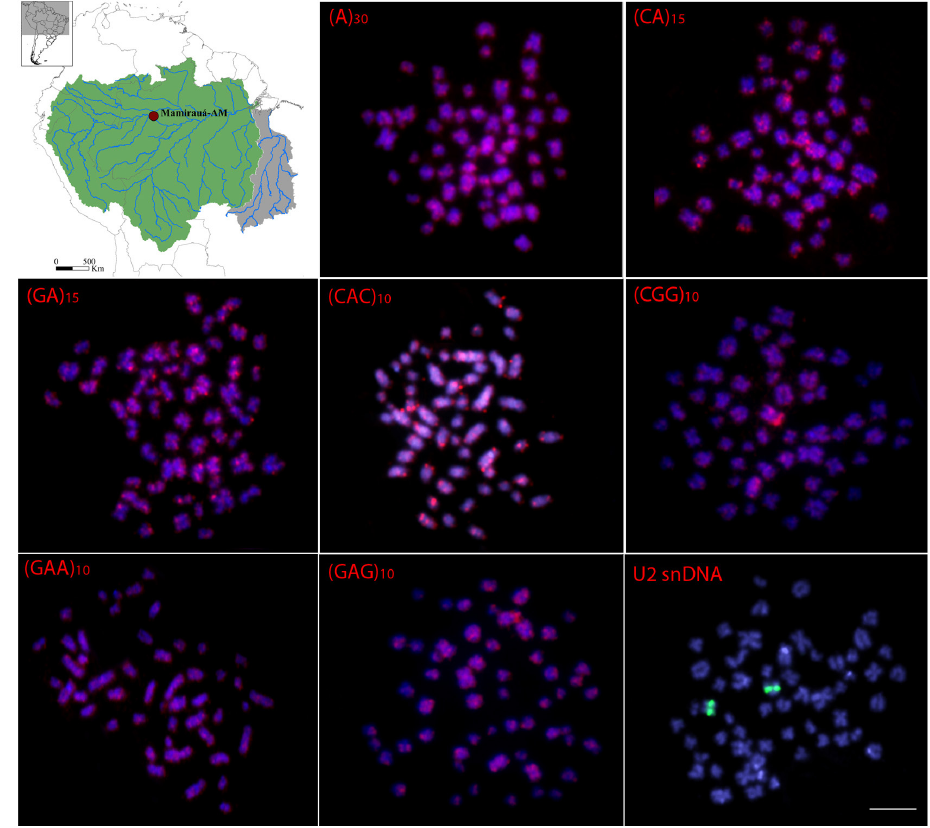
FIGURE 4 | Metaphase plates of Arapaima gigas from Mamirauá (MAM) population (Amazon River basin) hybridized with repetitive DNA sequences, including mono-, di- and trinucleotide microsatellites and the multigene families U2 snDNA. Bar=5